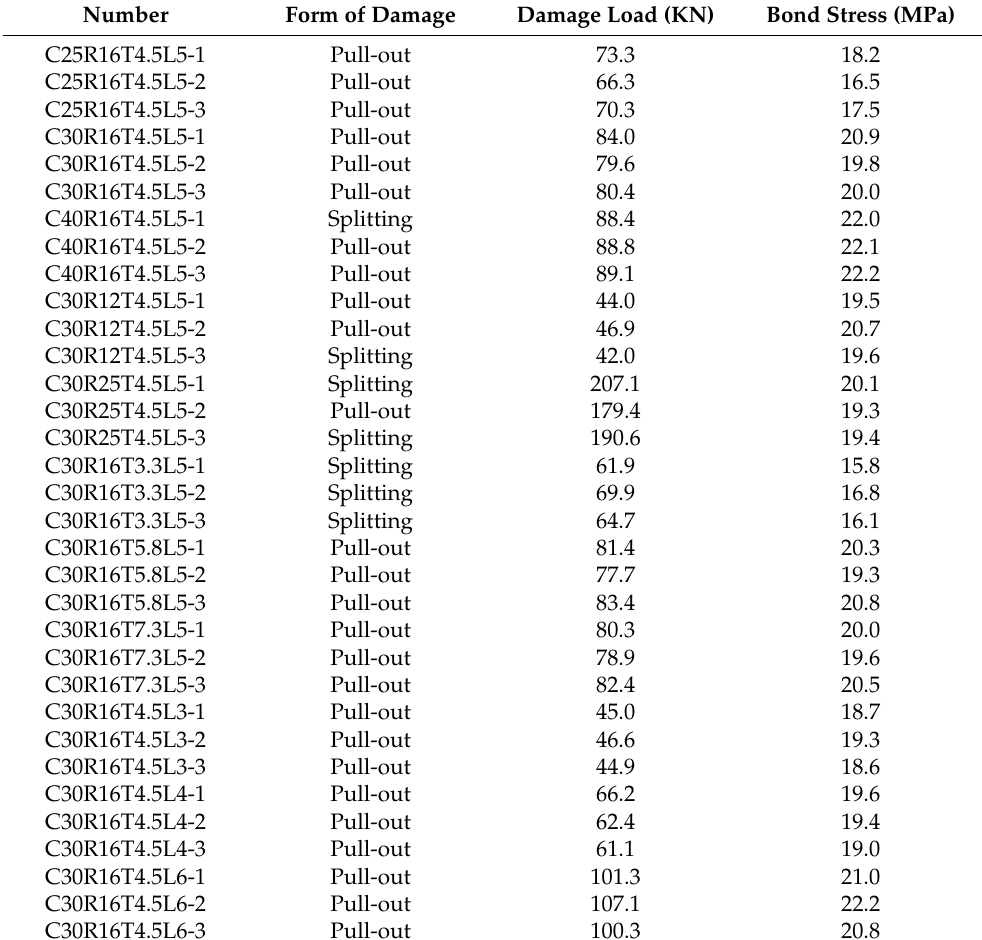
Table 9. The test results of bond strength between duplex stainless steel bars and